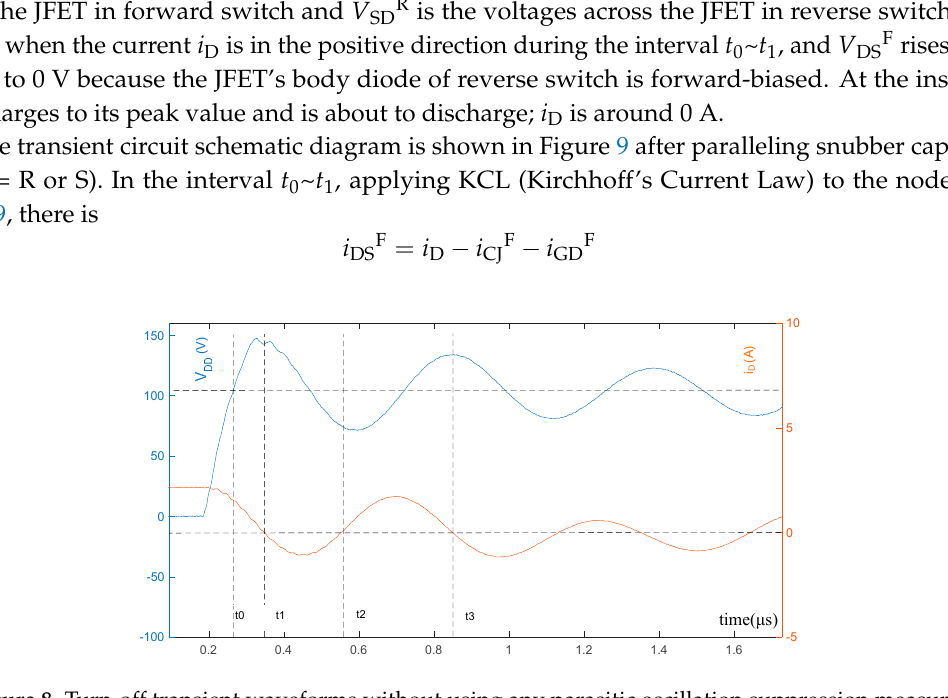
Figure 8. Turn-off transient waveforms without using any parasitic oscillation suppression measures ( V in = 103 V, i L = 2.0 A).